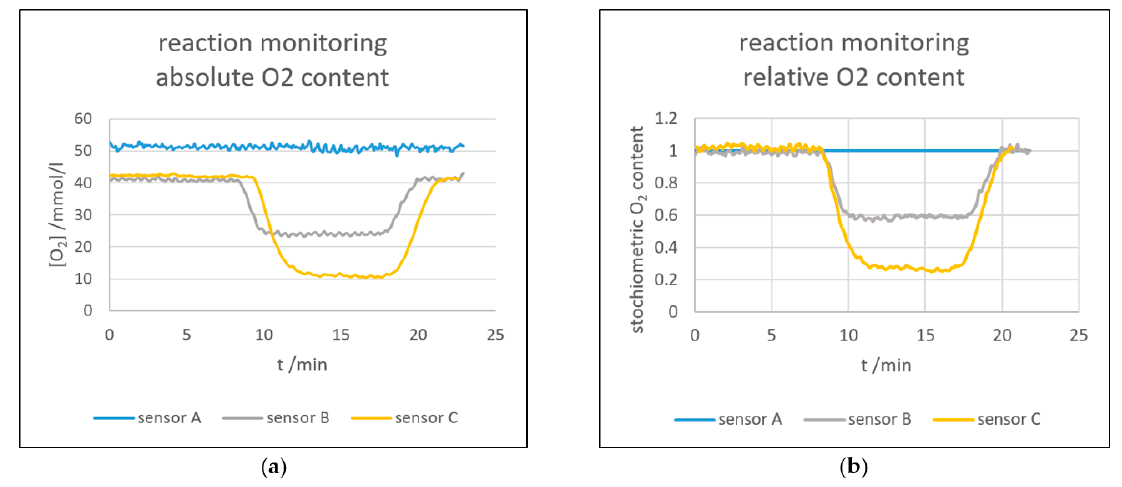
Figure 6. ( a ) absolute values of O 2 measurements before, during and after the Grignard reaction; ( b ) dividing the oxygen concentrations by the sensor A control value (correcting the time delay and dilution factor) lead to stoichiometric oxygen consumption at different points of the